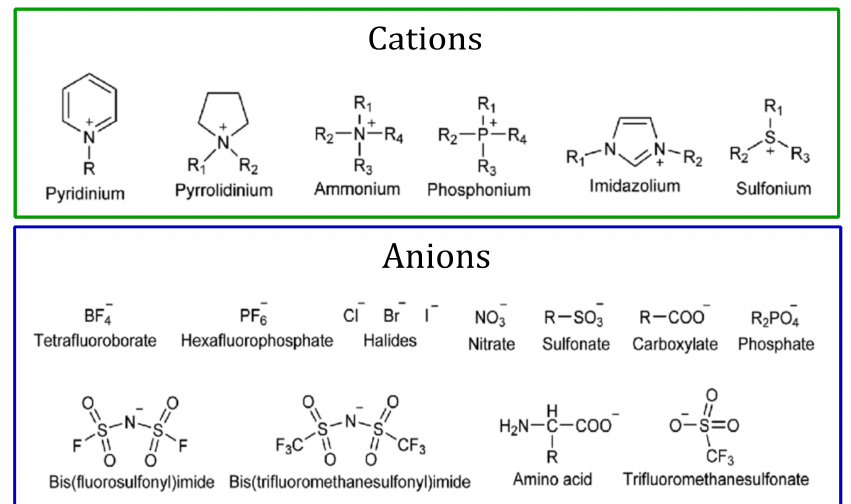
Figure 1. Typical cations and anions in ionic liquids. Typical basis of the cations are ammonium, imidazolium, sulfonium, piperidinium, and pyridinium ions. Halides, tetrafluoroborate, nitrate, sulfonate, carboxylate, phosphate, amino acid, among others, serve as a base of the anions for the preparation of